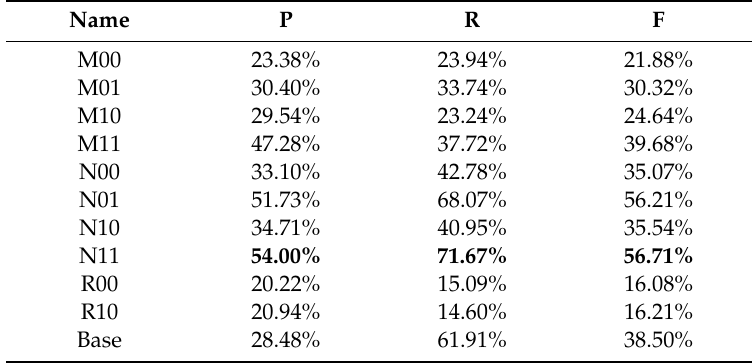
Table 2. Results in various conditions. P = precision; R = recall; F = F-measure.